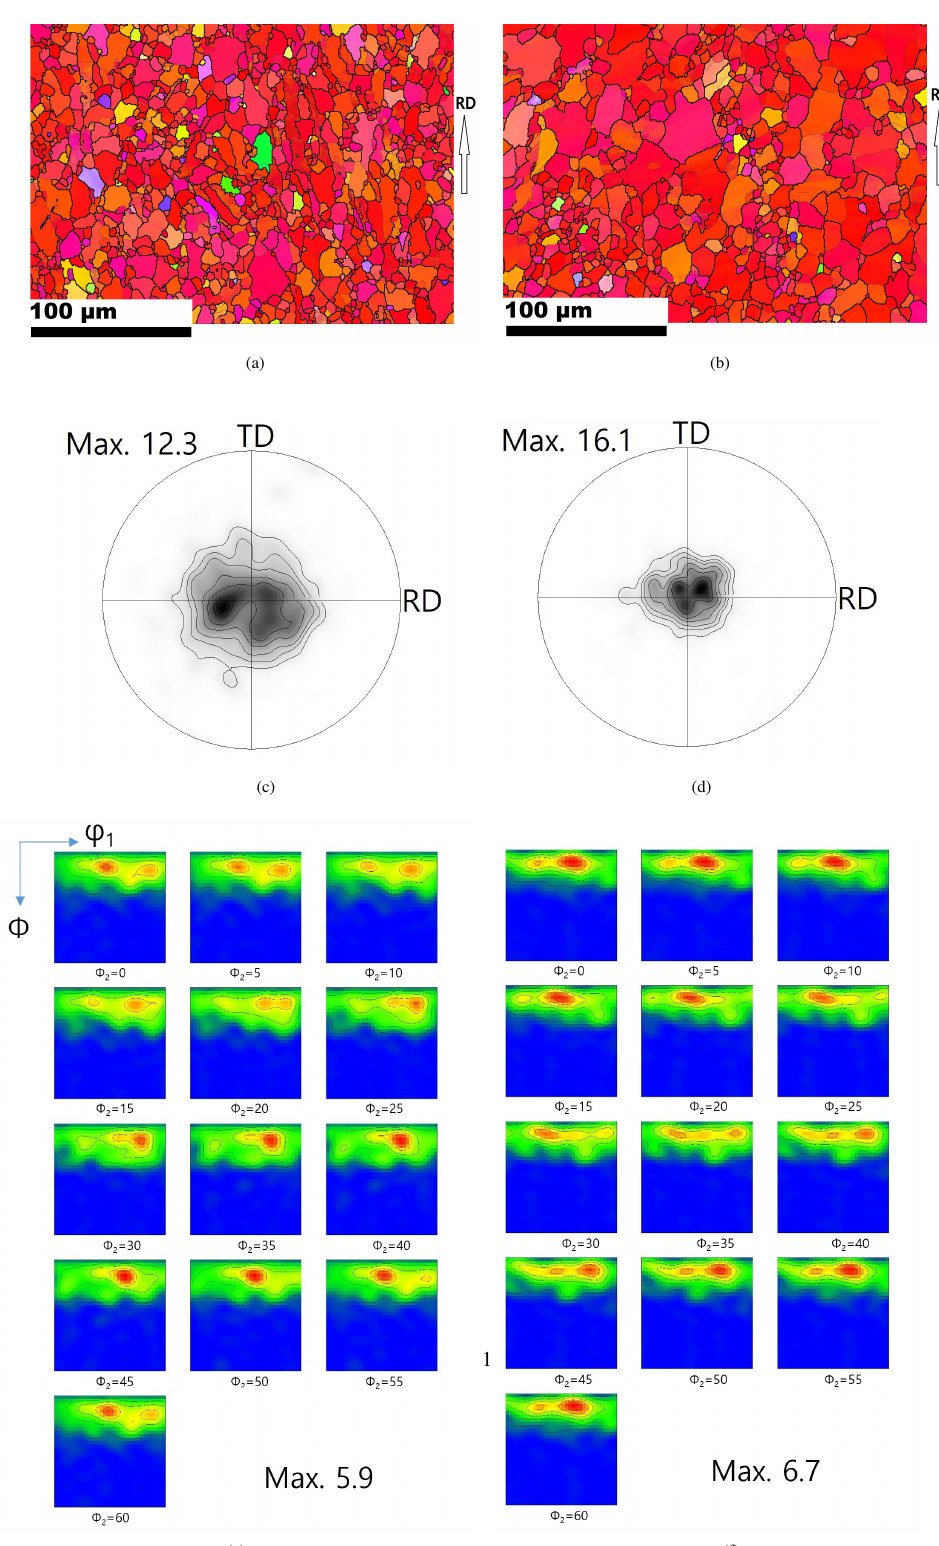
Figure 2. Inverse pole figures (IPFs) maps, pole figures (PFs) and orientation distribution functions (ODFs) of the initial sheets. PF contours: 1, 2, 3, 5, 7, 10. ODF contours: 1, 2, 3, 4, 5, 6. IPFs for ( a ) TRC, and ( b ) IC. 0001 PFs for ( c ) TRC, and ( d ) IC. ODFs for ( e ) TRC, and ( f )